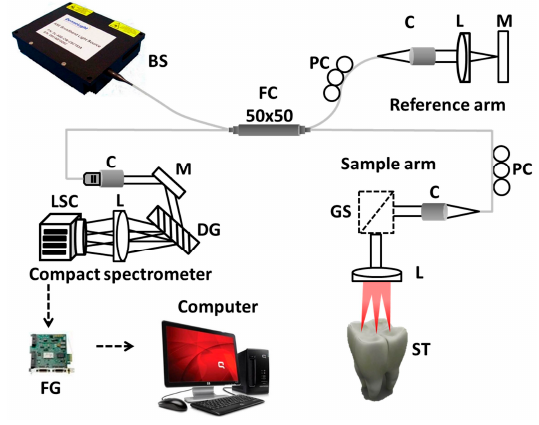
Figure 1. Schematic diagram of the spectral-domain optical coherence tomography (SD-OCT) system. Note the use of the following acronyms in the figure: BS: broadband source, C: collimator, DG: diffraction grating, FC: fiber coupler, FG: frame grabber, GS: galvanoscanner, L: lens, LSC: line